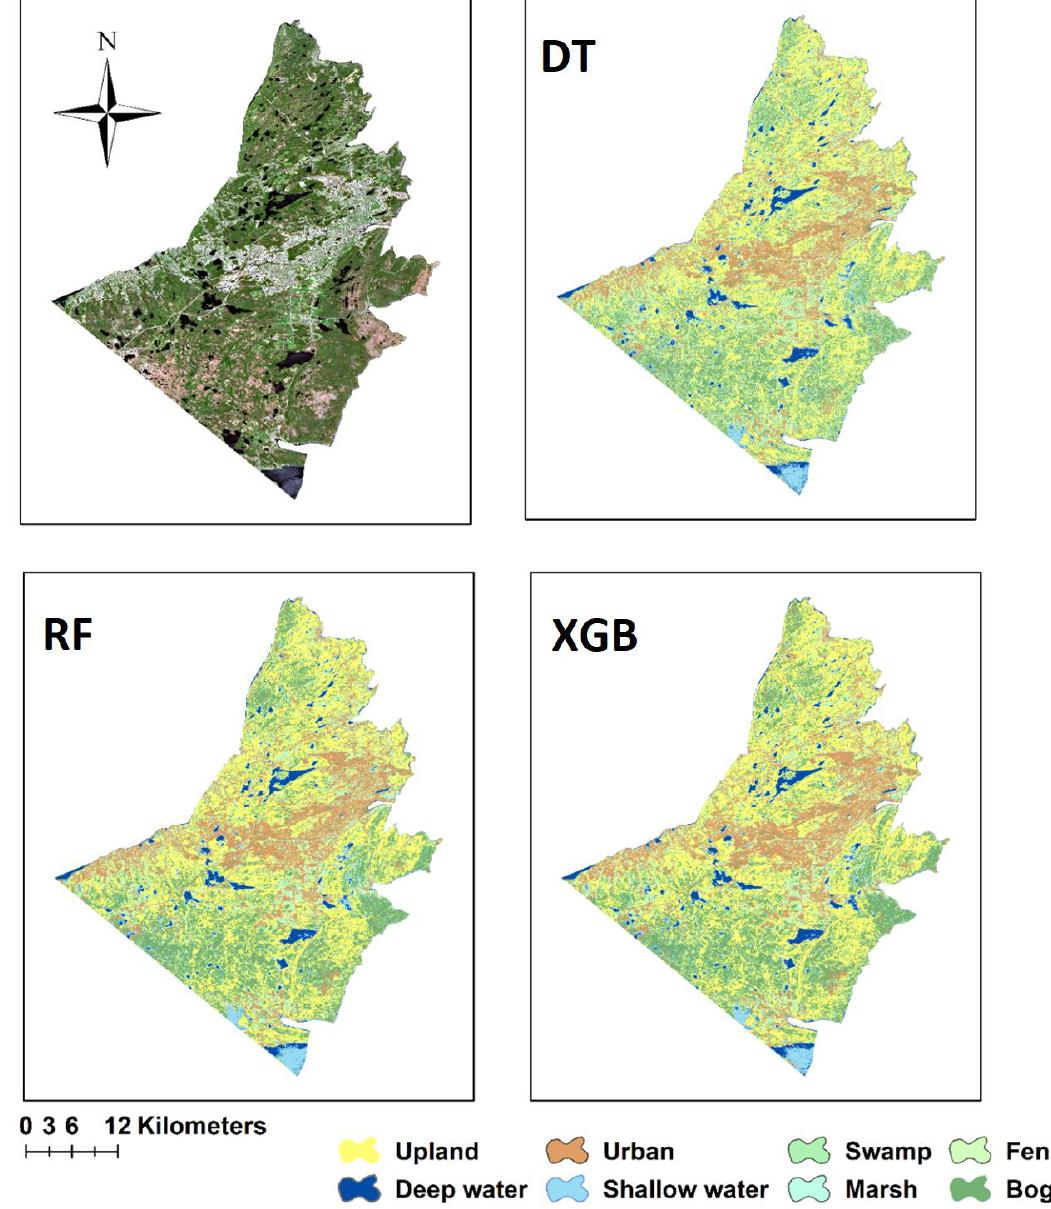
Table 3 . Implementation of the DT in the GEE code editor. Maps and confusion matrices of the classified landscape of the study area of the Avalon using the tree-based classifiers of the DT, RF, and XGB implemented in the GEE code